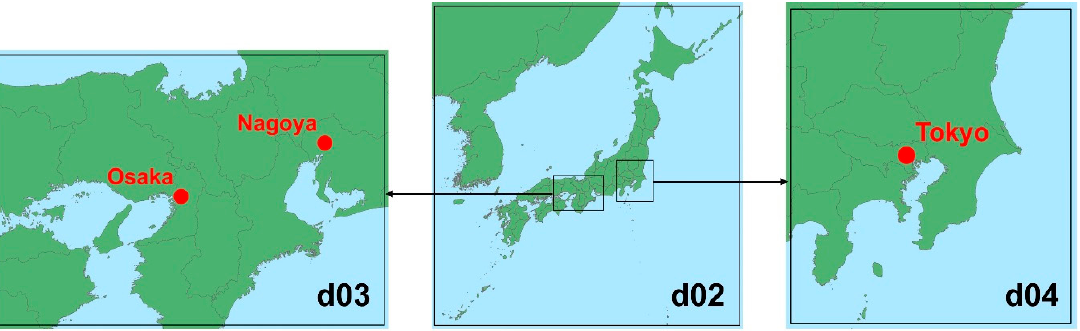
Figure 1. Target domains d02, d03, and d04, which are mainly discussed in this paper.